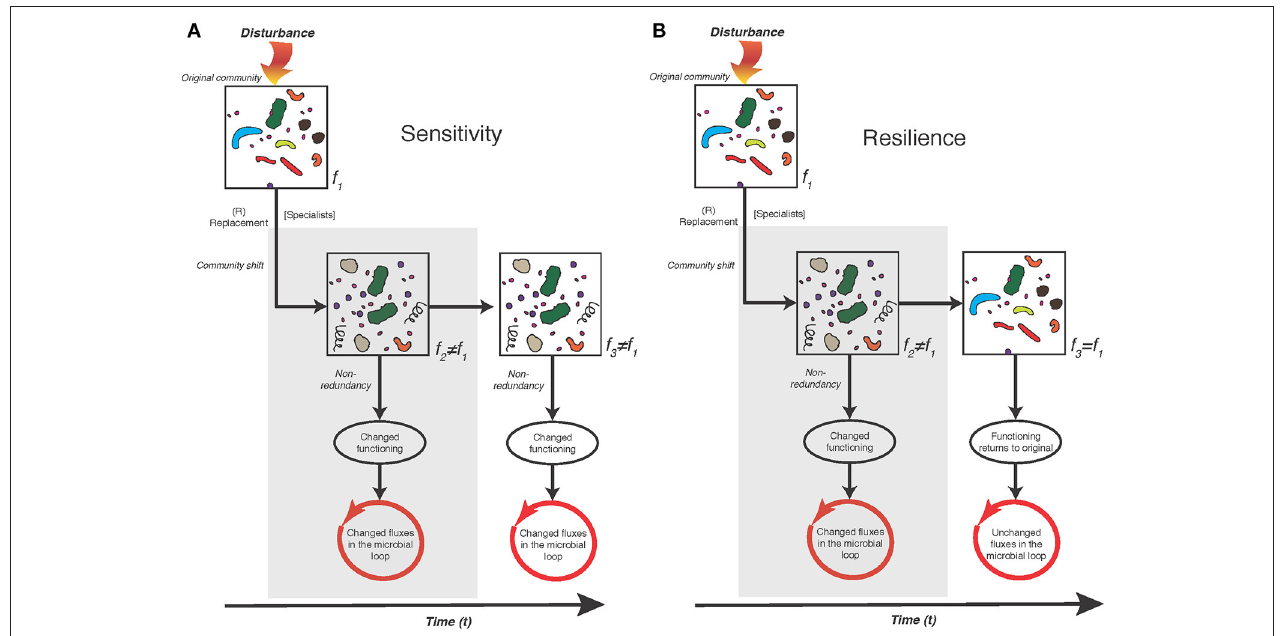
FIGURE 3 | Conceptual diagram of two possible scenarios of Baltic Sea bacterioplankton community dynamics, i.e., sensitivity (A) , and resilience (B) . In both the sensitivity and resilience scenario an environmental disturbance leads to the replacement of individual bacterioplankton populations and changed community functioning with potential impact on the microbial loop and carbon cycling. The scenarios differ in that over time the replacement of individual bacterioplankton populations and changed community functioning remains in (A) , but returns to similar individual bacterioplankton populations and community functioning as the original community in (B) . Scenarios with empirical evidence of significant effects on bacterioplankton community composition and functioning in the present review is the impact of dissolved organic nitrogen (DON) additions and increased temperatures Bergen et al. (2016), Vaquer-Sunyer et al. (2015). However, for Baltic Sea data, the lack of long-term studies precludes conclusions regarding whether the sensitivity or resilience scenario are the most prominent—currently studies have been designed primarily to determine the extent of the initial sensitivity (gray filled